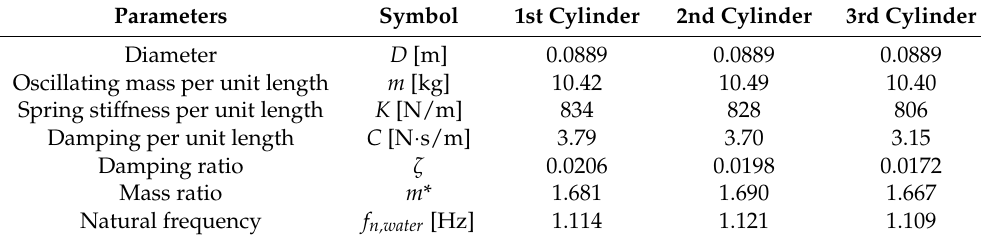
Figure 1. Physical model of three cylinder with roughness. Table 1. Parameters of the three-cylinder